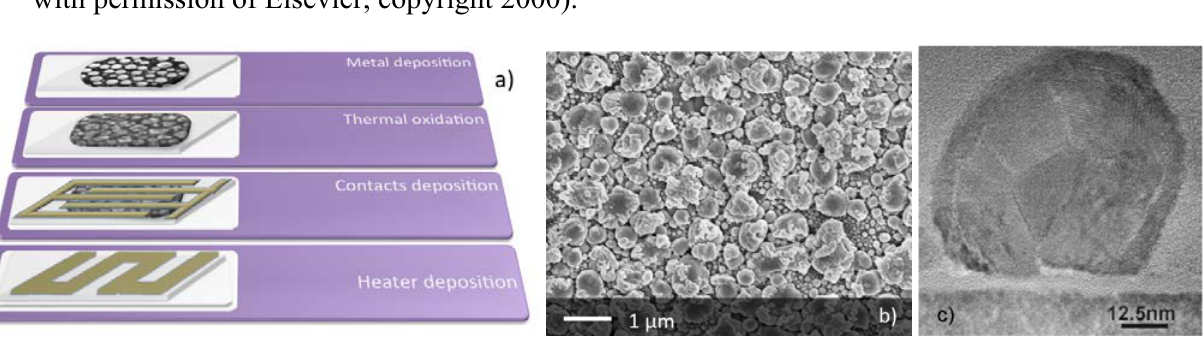
layer prepared by the RGTO 2